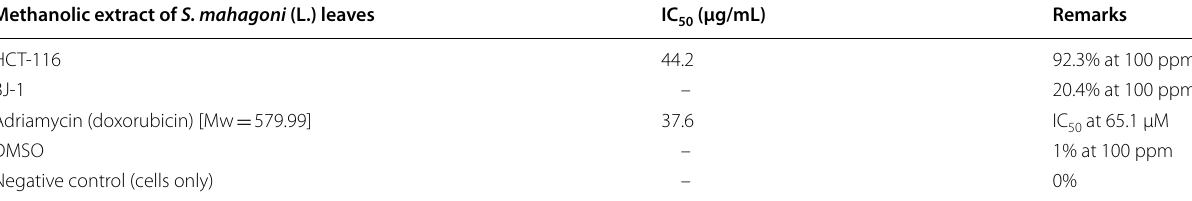
IC 50 lethal sample concentration that caused the death of 50% of cells in 48 h =